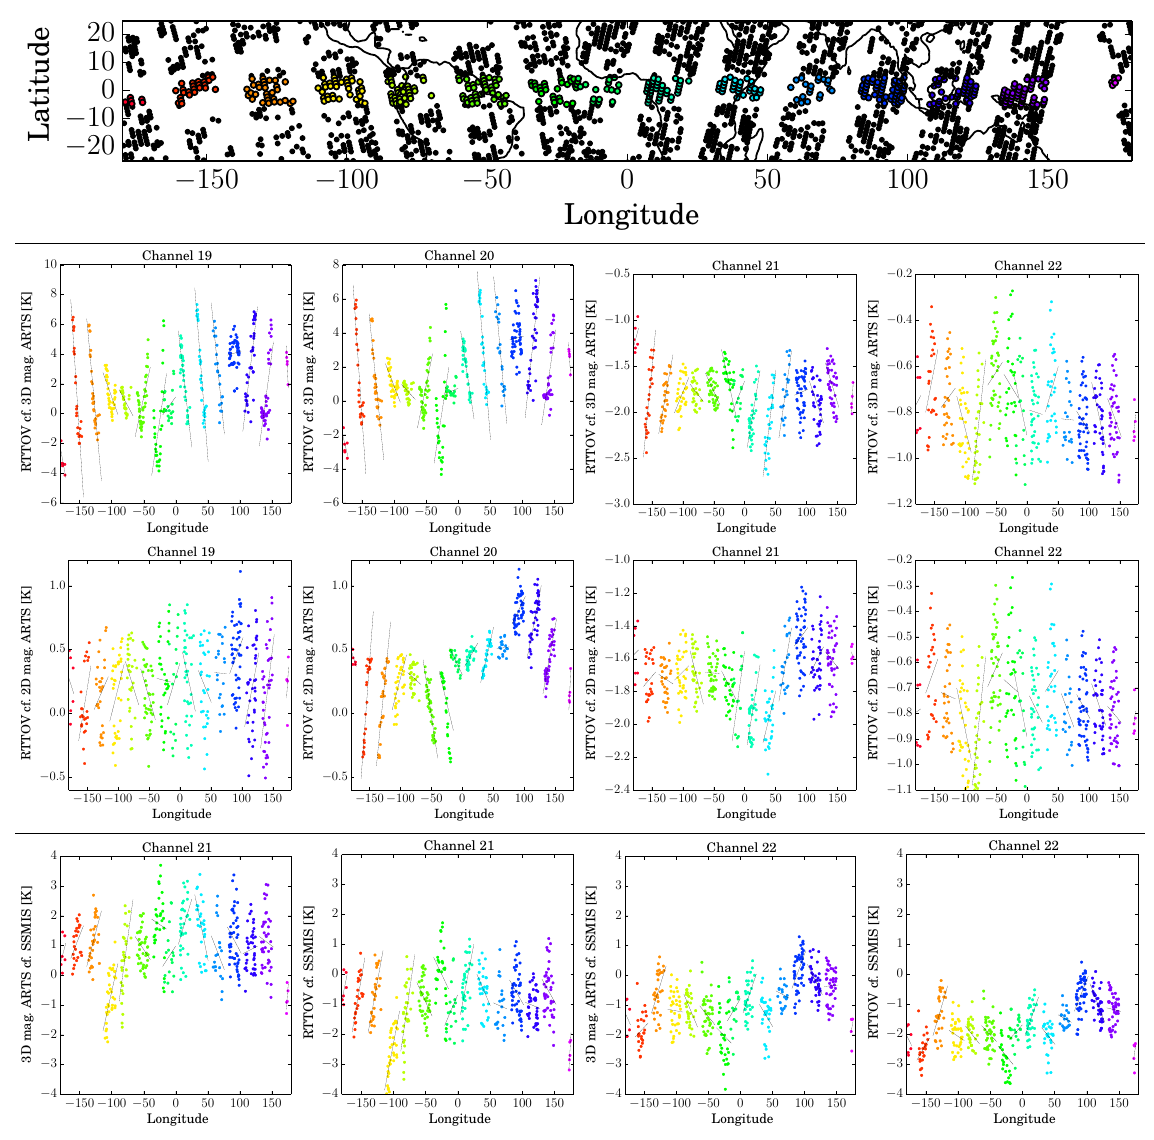
Figure 13. The swath dependencies around the equatorial crossings of this study. The first row shows the map of the data. Color-coding is the same in this map as in the other plots where the swath from one orbit has its own colors; black circles are not used because they are more than 5 ◦ from the equator (5 ◦ was just arbitrarily chosen as the limit). The y axis label in the other plots overlap with labels in Figs. 6 to 11. Channels are named in the plot titles. Linear regression for brightness temperature differences was performed over longitude and the best-fit line is drawn between ± 20% of the longitude range of the data from each orbit. The first two rows of the regression plots represent the model comparison and the last row represents the comparison between the models and SSMIS